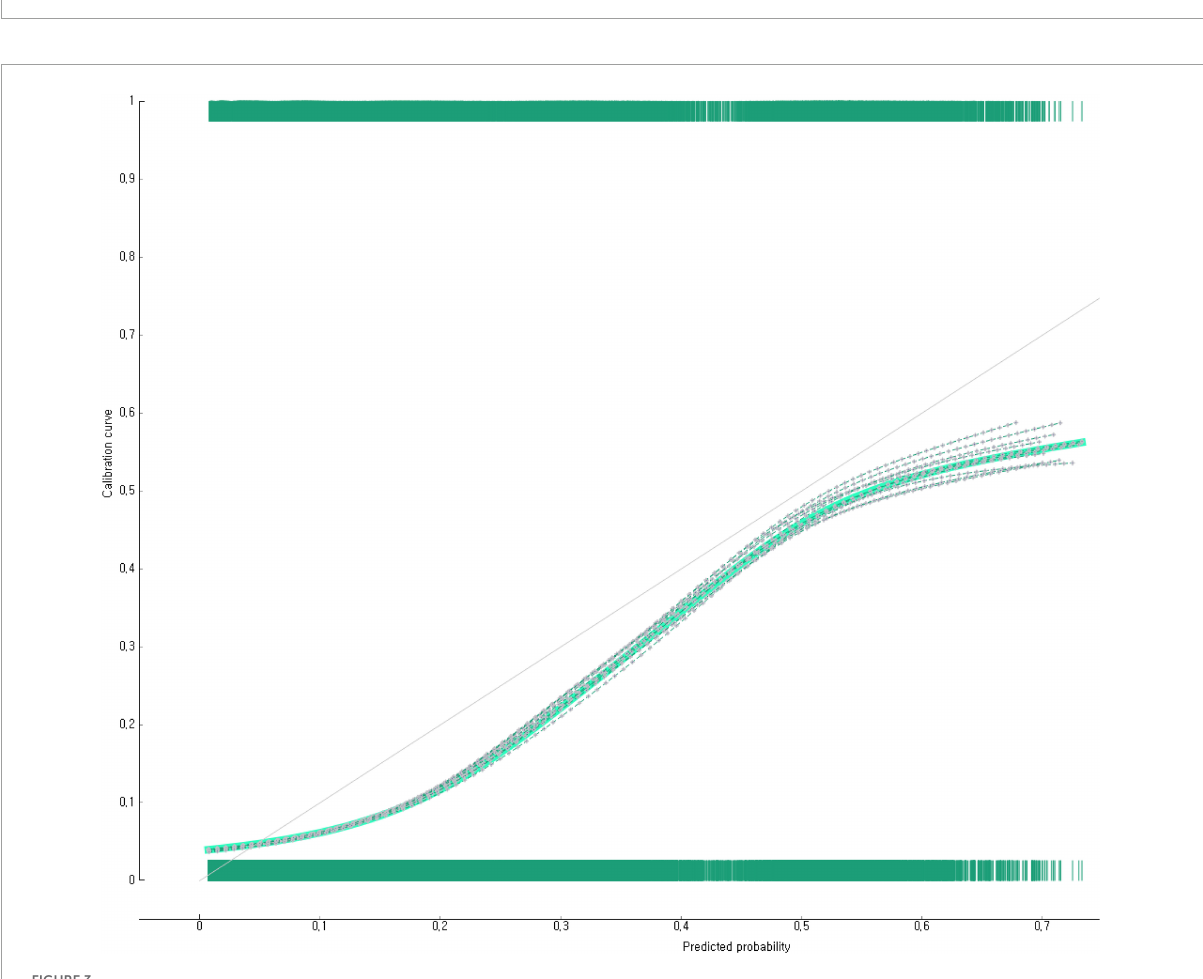
FIGURE2 A nomogram predicting the South Korean adolescent group vulnerable to suicidal ideation: (1) depression experience in the past 12 months (1 = no or 2 = yes), (2) subjective stress recognition (1 = high, 2 = moderate, or 3 = none), (3) experience of loneliness in the last 12 months (1 = rarely, 2 = moderate, or 3 = frequent), (4) subjective economic status (1 = high, 2 = medium, or 3 = low), (5) grade (1 = 7th grade, 2 = 8th grade, 3 = 9th grade, 4 = 10th grade, 5 = 11th grade, or 6 = 12th grade), (6) academic performance (1 = high, 2 = medium-high, 3 = medium, 4 = medium-low, or 5 = low), and (7) changes in economic status during the COVID-19 pandemic (1 = strongly agree, 2 = agree, 3 = disagree, or 4 = strongly disagree).